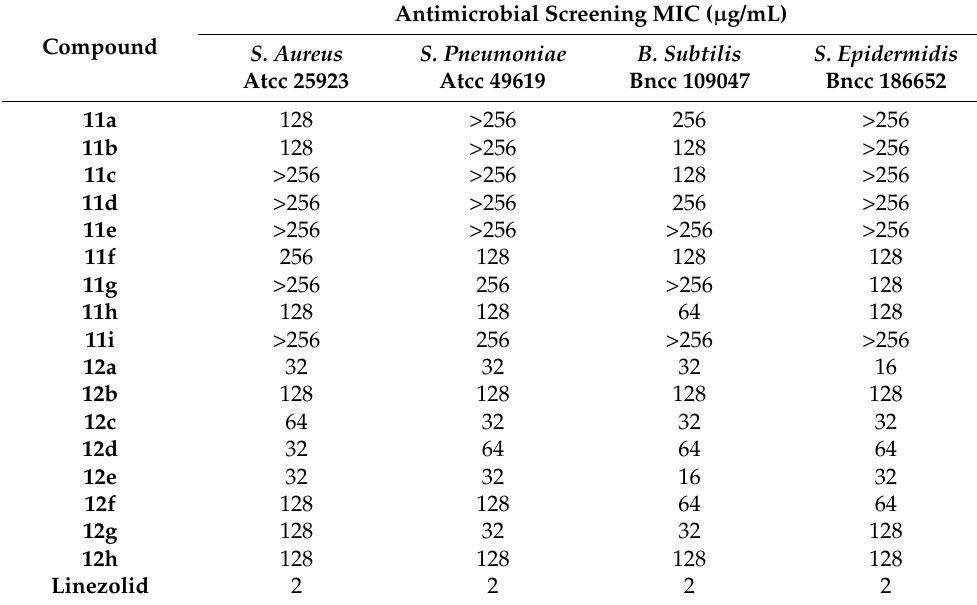
Table 1. In vitro antibacterial activity of target derivatives (MIC: µ g/mL). Antimicrobial Screening MIC ( µ Compound